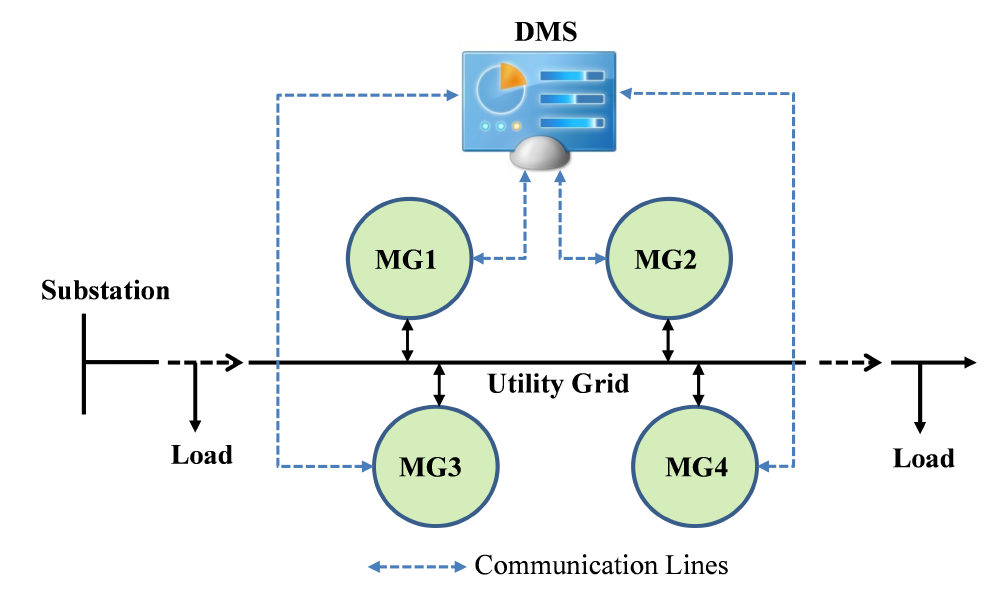
Figure 1. Example of networked